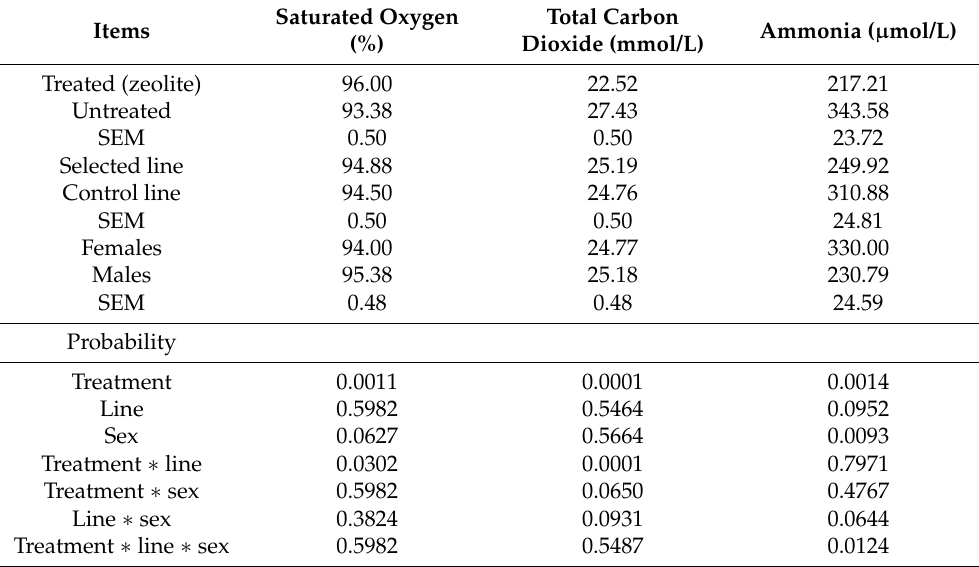
Table 4. Least square means for blood gases as affected by treatment, line, and sex effects.